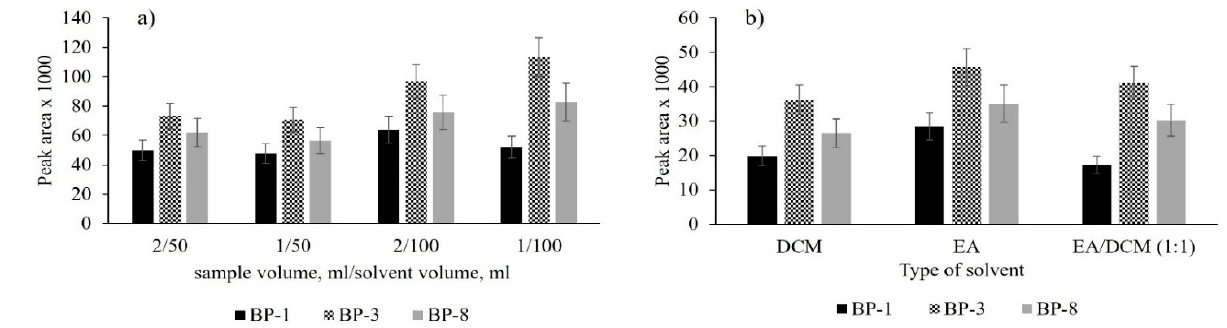
Figure 2. Optimization of MEPS method, sample spiked concentration 100 µ g L − 1 , ( a ) effect of sample volume (1, 2 mL) and eluent volume (50, 100 µL) (EA/DCM, 1:1, v / v ); ( b ) selection of eluent (sample volume 1 mL, eluent volume 100 µL).